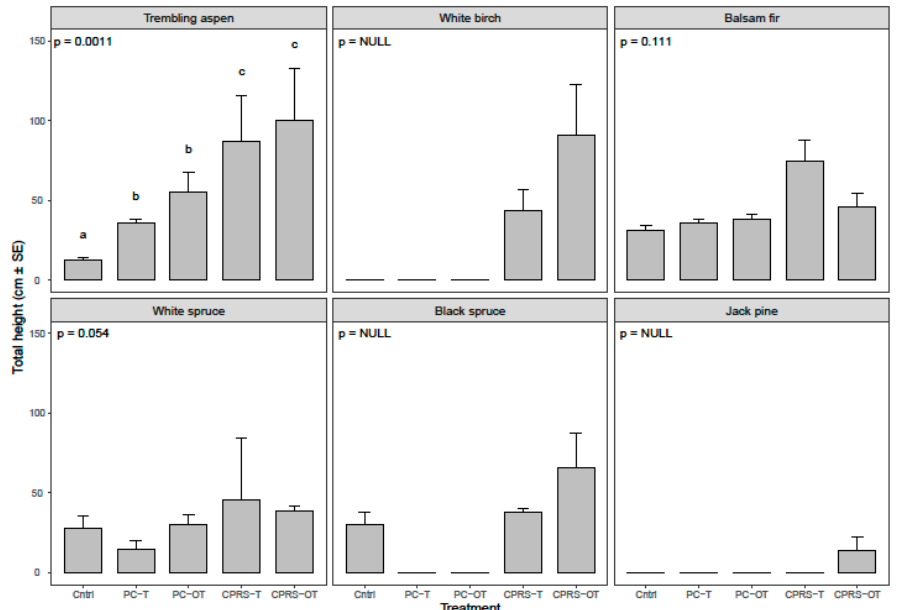
Figure 1. Mean regeneration height (cm ± Standard error) on and o ff machinery trails (190 micro-plots) across treatments and species 7 to 19 years after treatment in the boreal mixed-woods of eastern Canada. Bars with the same letter are not significantly di ff erent at alpha = 0.05, according to the Tukey HSD test. Treatments are Cntrl: unharvested control; PC: partial cut; CPRS: clear-cut with protection of regeneration and positions are T: machinery trails; OT: o ff machinery trails. See Table 4 for the number of observations.